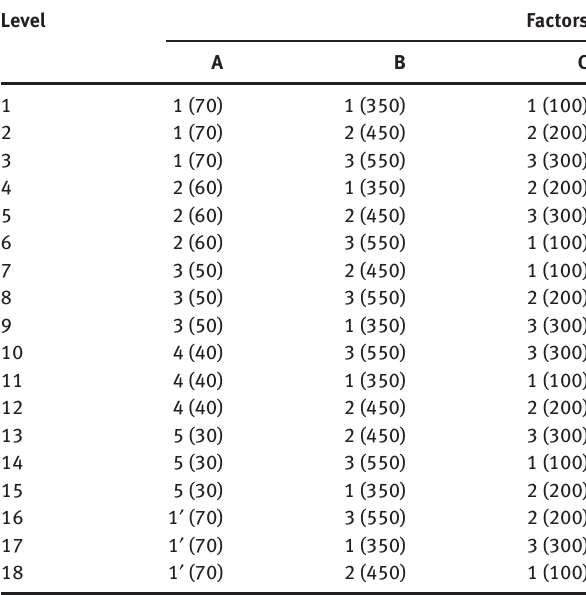
modified orthogonal array experimental design. Table 3: L 18 Level Factors